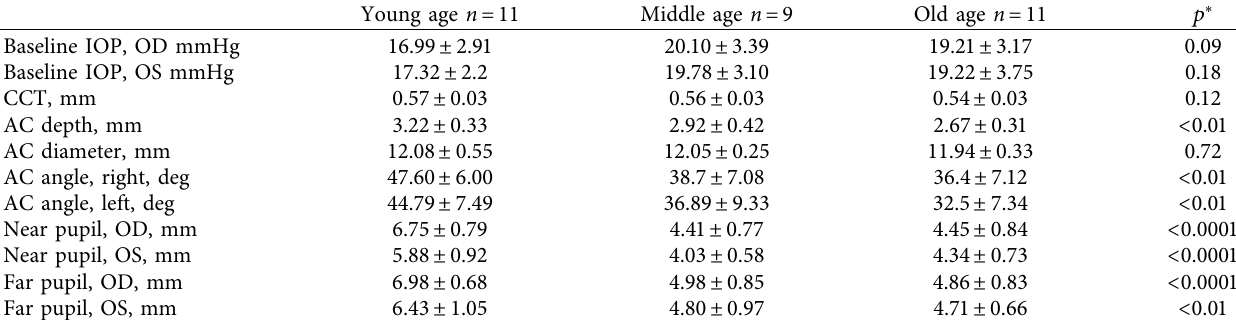
Table 2: Ocular characteristics of study participants.